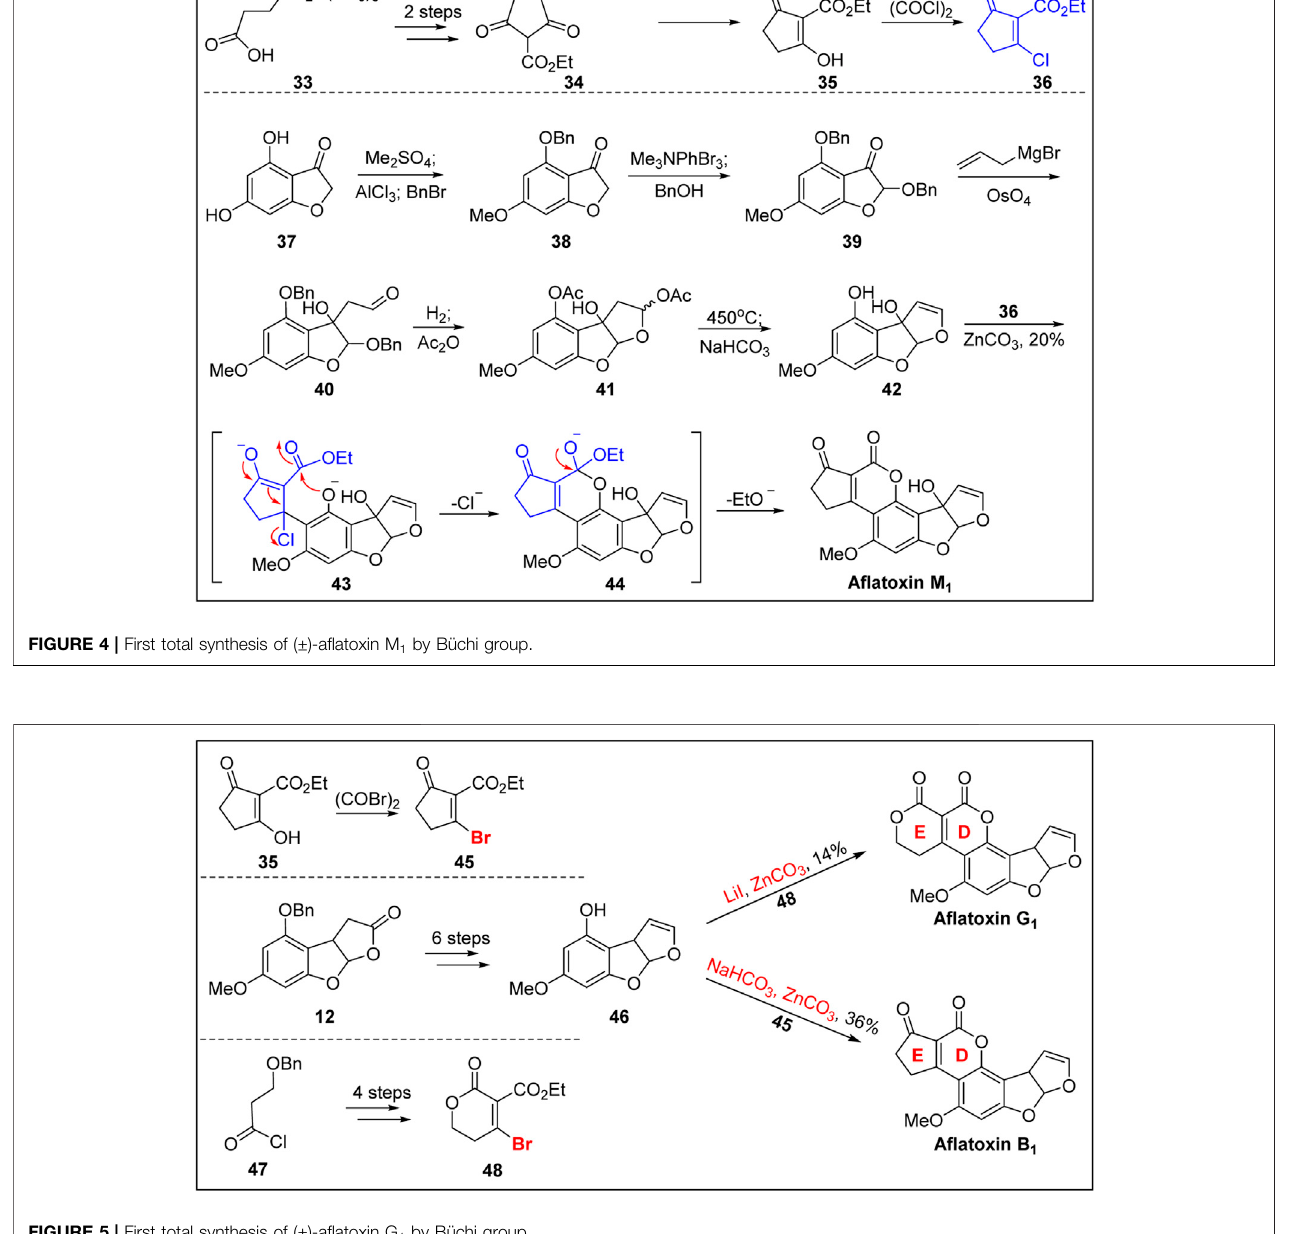
1 by Büchi group.